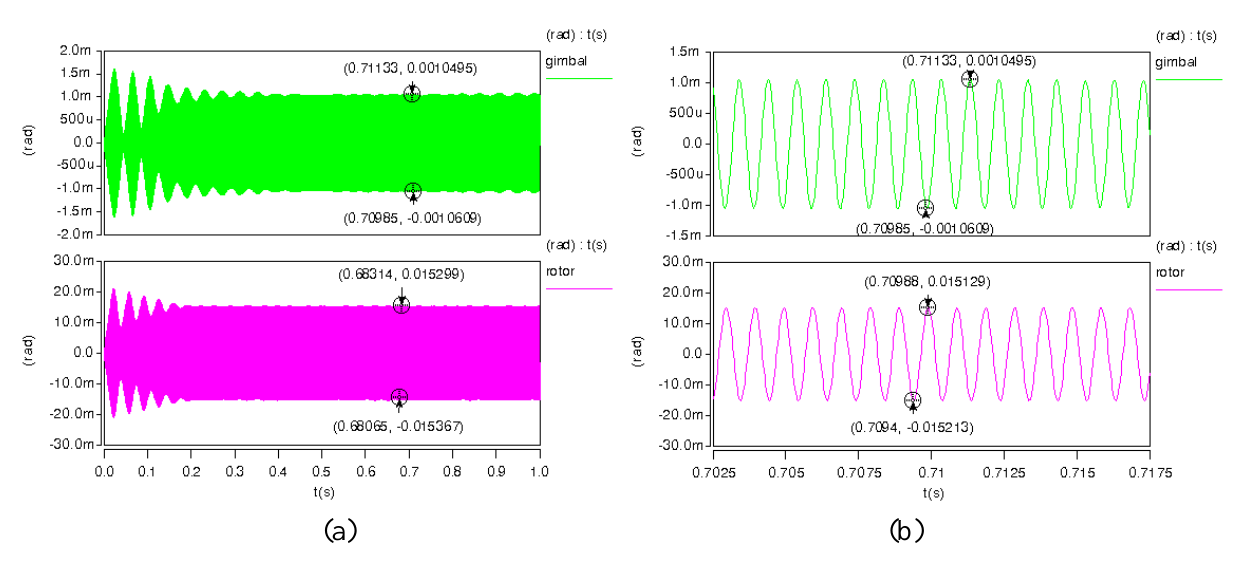
Figure 8. The power of voltage sources in a